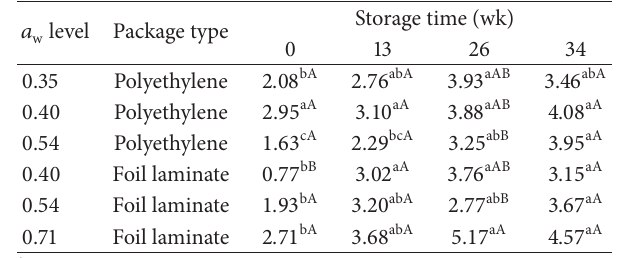
Table 2: Changes in 𝐿 ∗ (0 to 100, dark to light) color values of dehydrated taro slices stored at different 𝑎 packaging materials 1 .